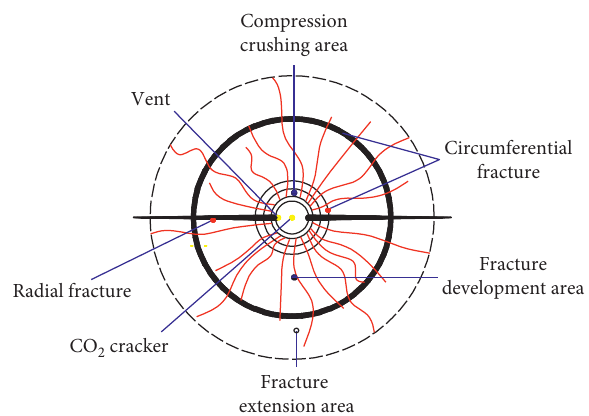
Figure 2: Fracture distribution of coal around the borehole caused by CO 2